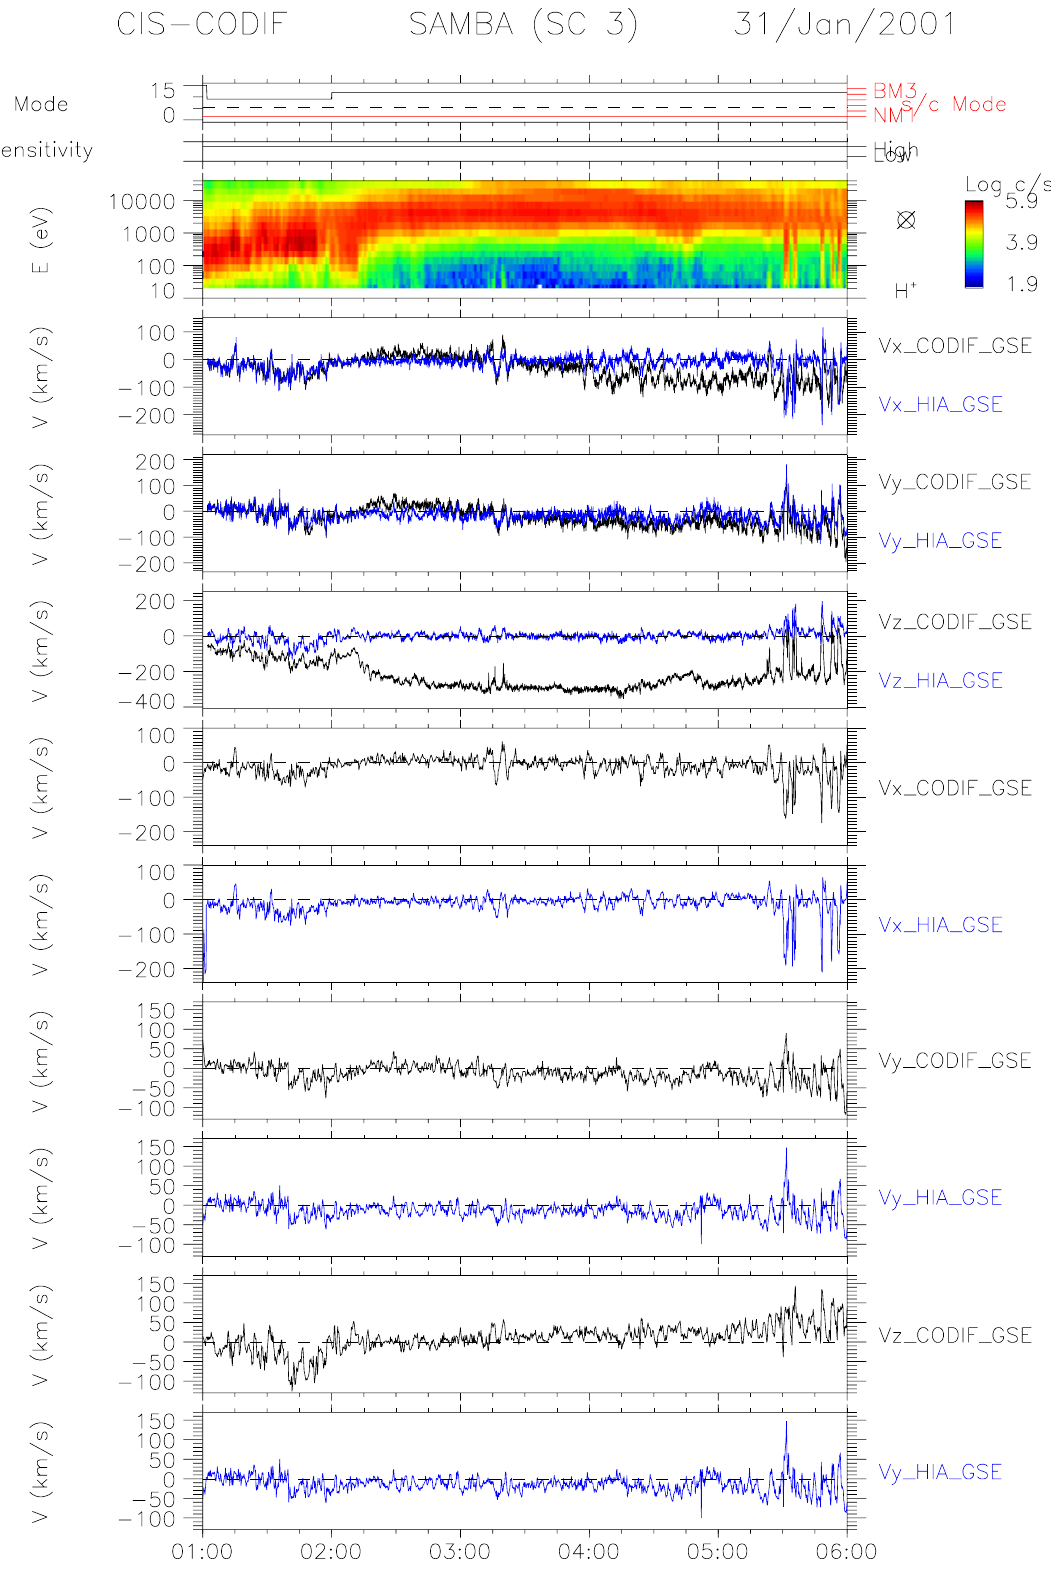
Fig. 19. Example showing the importance of the calibrations, from top to bottom: instrument modes, and CODIF and HIA sensitivities, energy-time spectrogram of CODIF for H + ions as a function of energy, on board calculated CODIF and HIA velocities (3 panels), velocities calculated on the ground using the 3D distribution functions, and correct efficiencies for HIA and CODIF (6